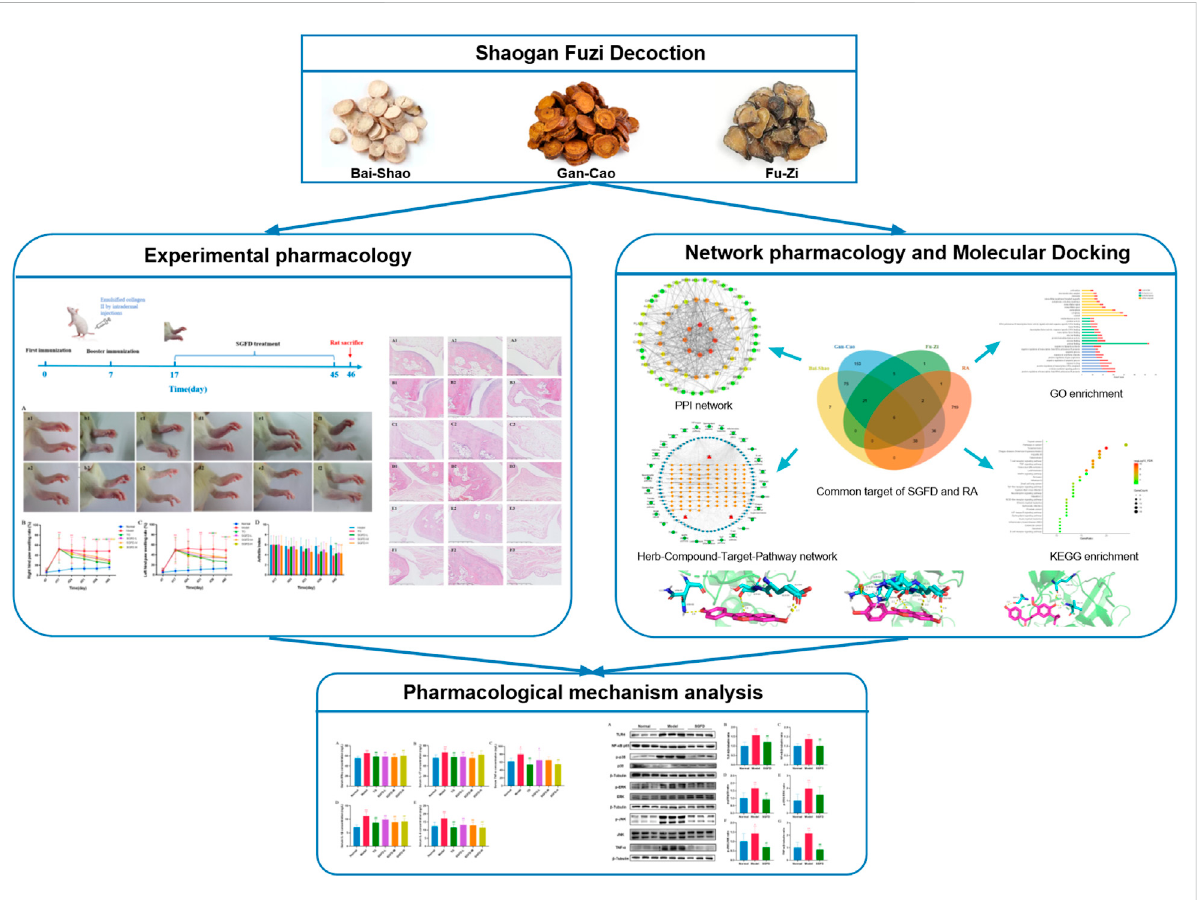
FIGURE 1 The fl owchart of this study based on an integration strategy of network pharmacology and experimental veri fi cation.